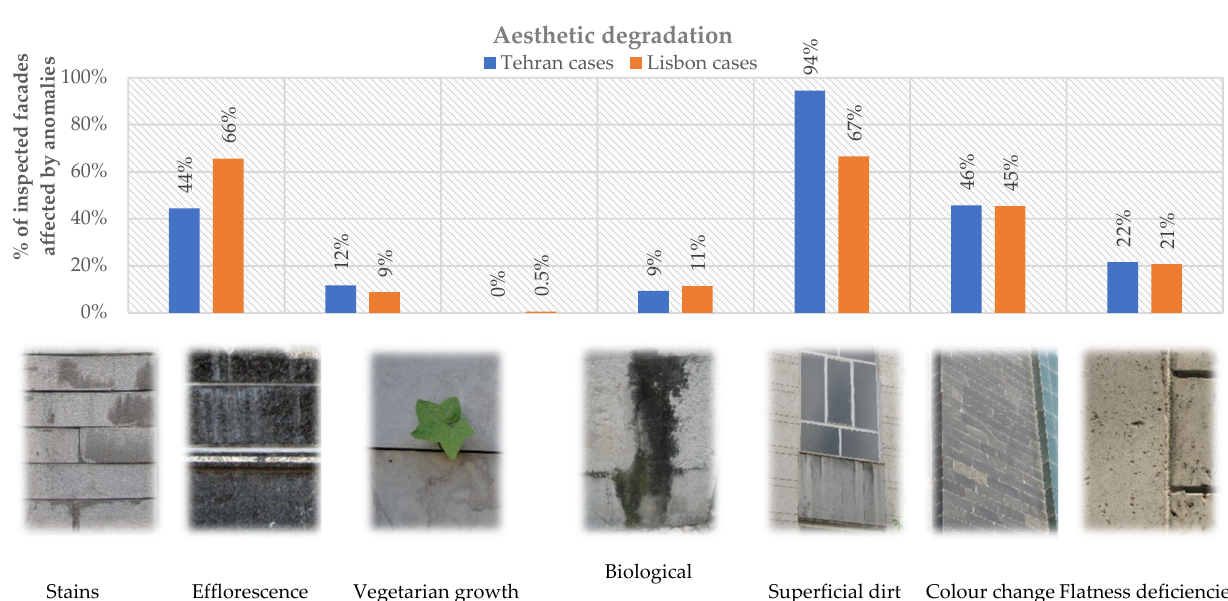
Figure 4. Frequency of the defects in the aesthetic anomalies group observed in the samples under analysis.